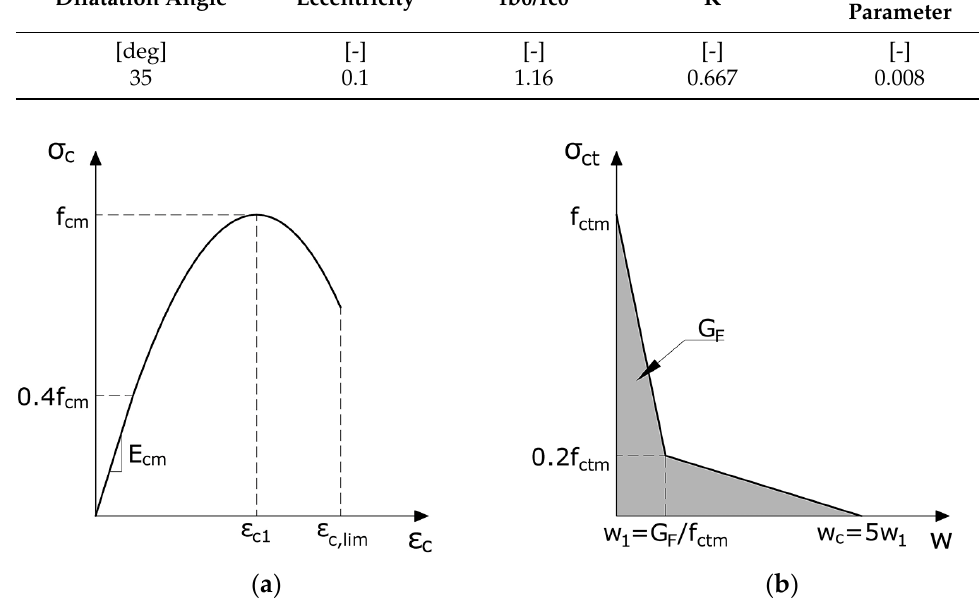
Figure 6. Concrete acc. MC2010 [4]: ( a ) Stress–strain relationship in compression; ( b ) Stress–crack opening in tension.